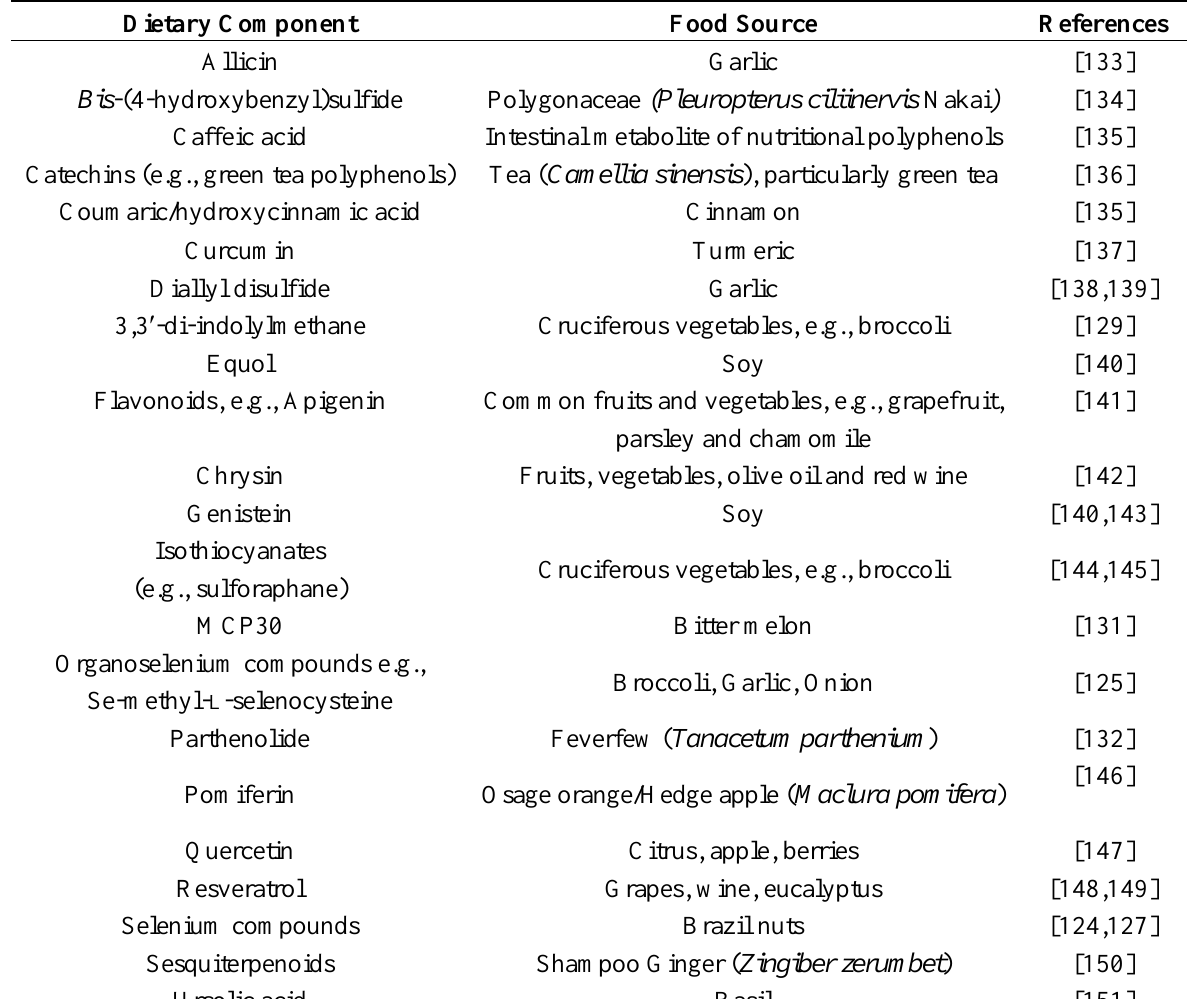
Table 3. Examples of dietary compounds identified as inhibiting HDAC